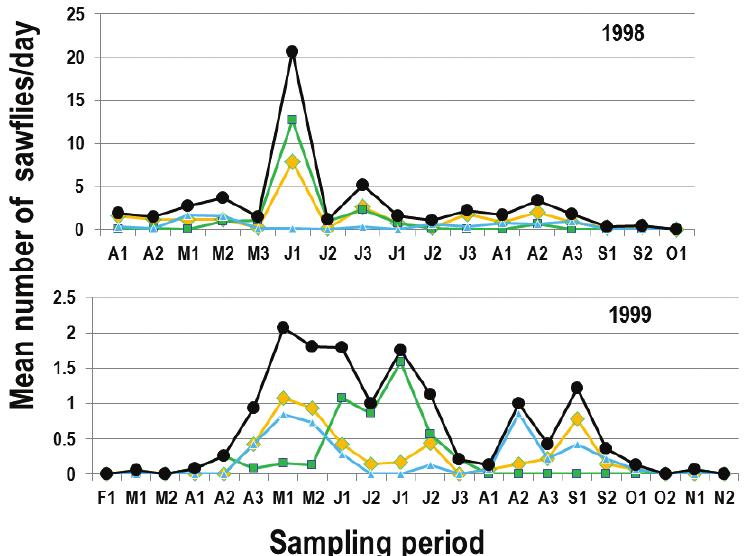
Figure 3. Sawfly abundances (mean per day per sampling period) varied over their flight periods in 1998 and 1999 in Dyke Marsh Wildlife Preserve, Virginia. Diamonds represent sawfly numbers in the ecotone; squares, forest; triangles, marsh; and circles, all three habitats combined. In 1998, sampling interval A1